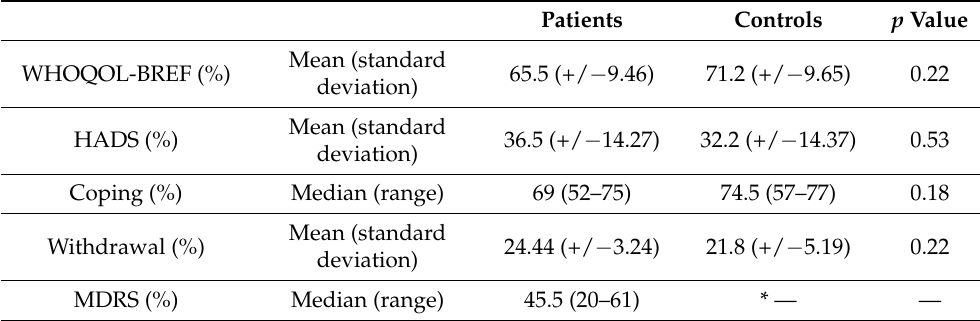
Table 4. Results from questionnaires.